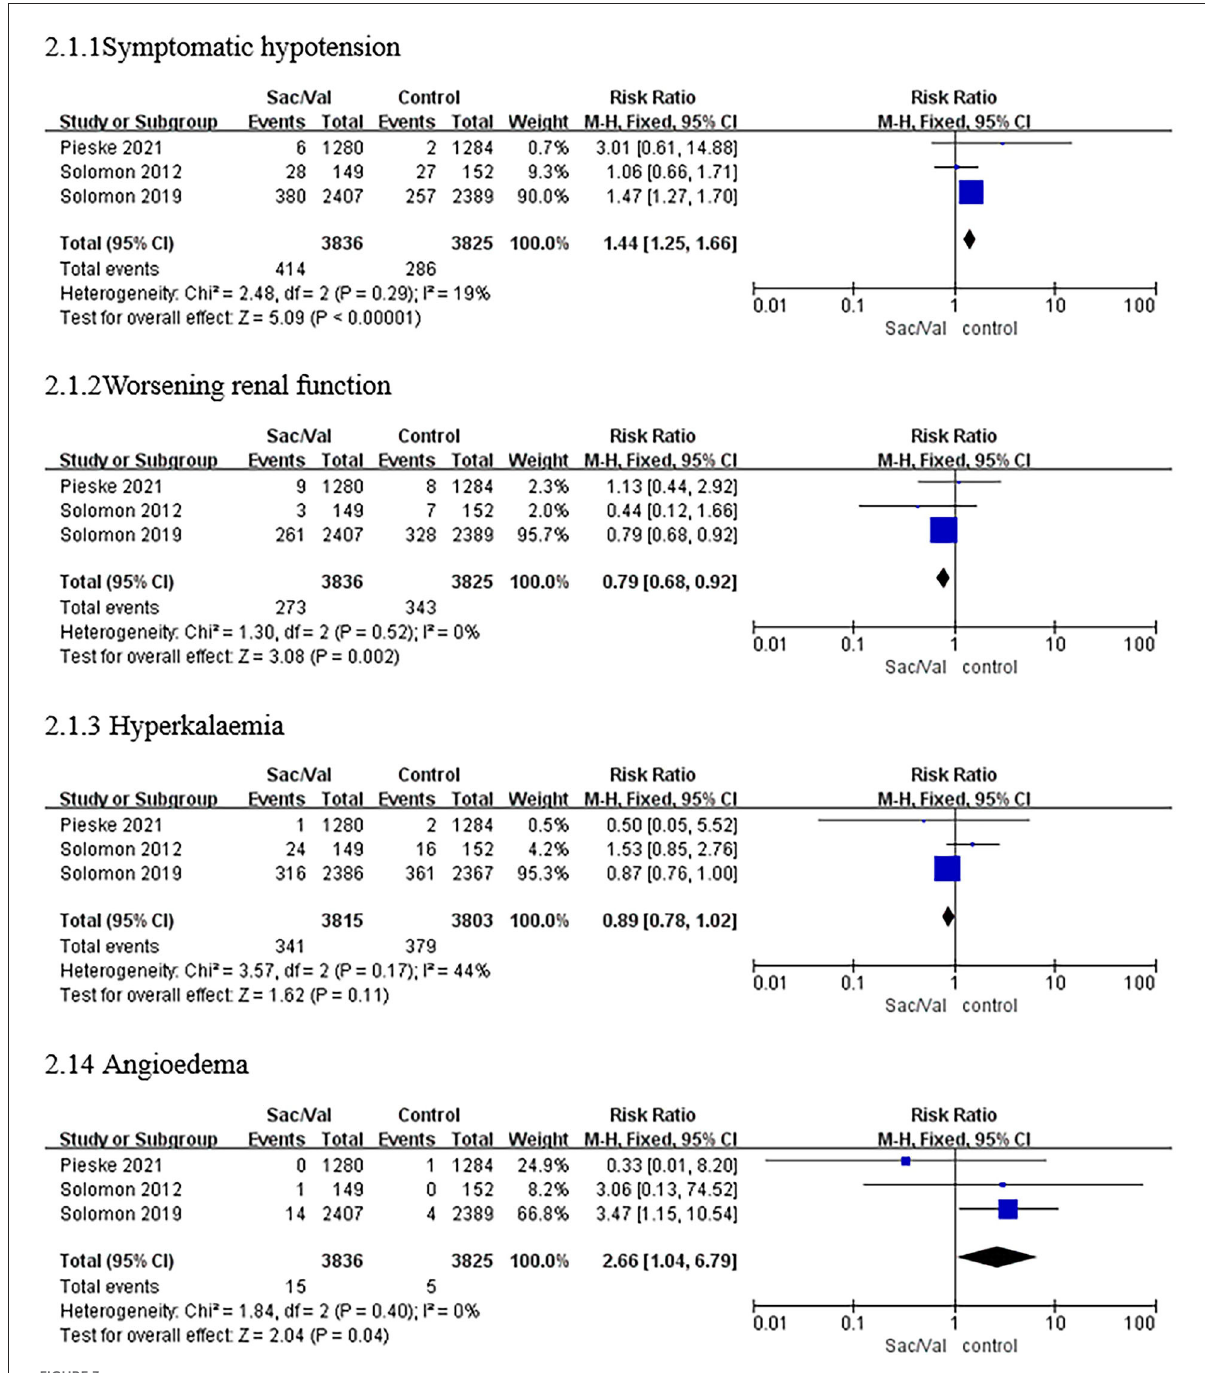
FIGURE3 A forest plot of the safety outcomes of symptomatic hypotension, worsening renal function, hyperkalemia ( ≥ 5.5 mmol/L), and angioedema. Worsening renal function was defined as a decrease in estimated glomerular filtration rate (eGFR) ≥ 35% or an increase in serum creatinine ≥ 0.5 mg/dl from baseline and a decrease in eGFR ≥ 25% from baseline or serum creatinine > 2.5 mg/dl. Sac/Val, sacubitril/valsartan; eGFR, estimated glomerular filtration rate.